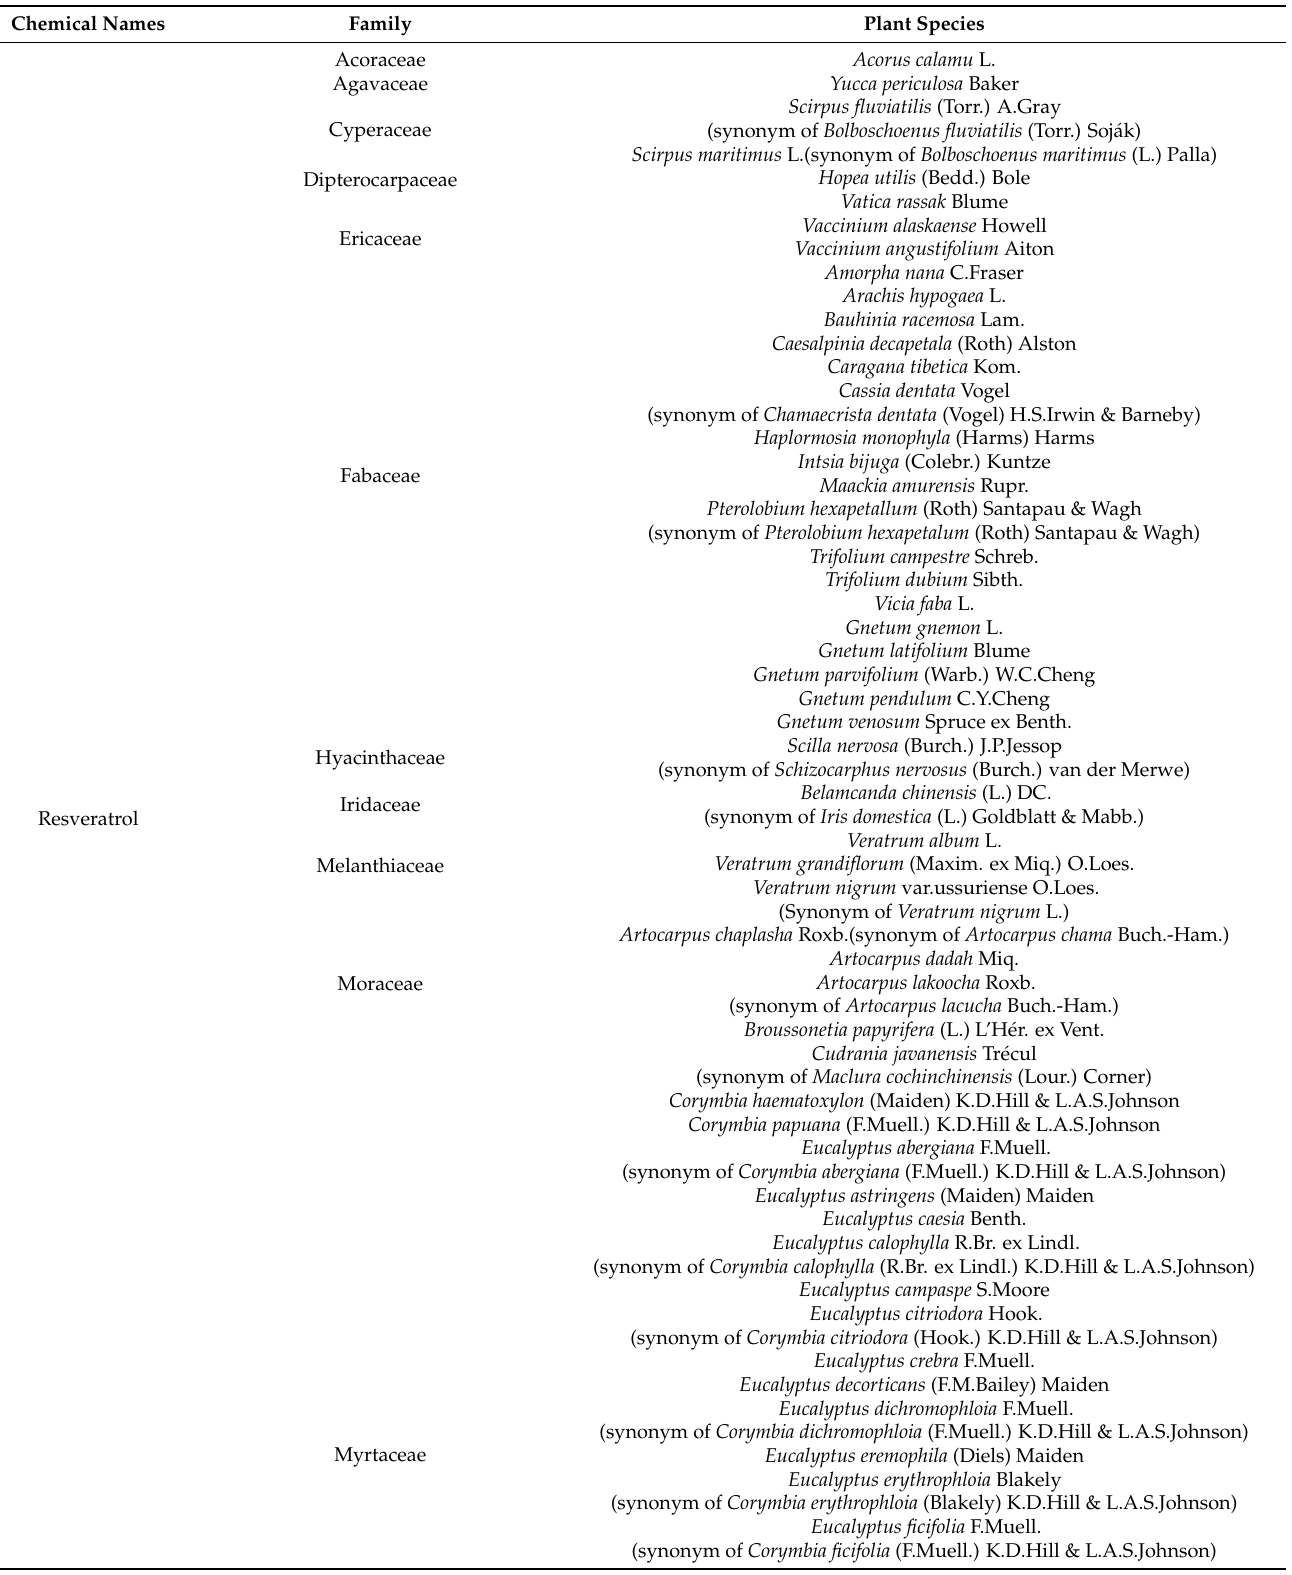
Table 1. List of plant sources containing resveratrol, oxyresveratrol, and piceatannol retrieved from the KNApSAcK